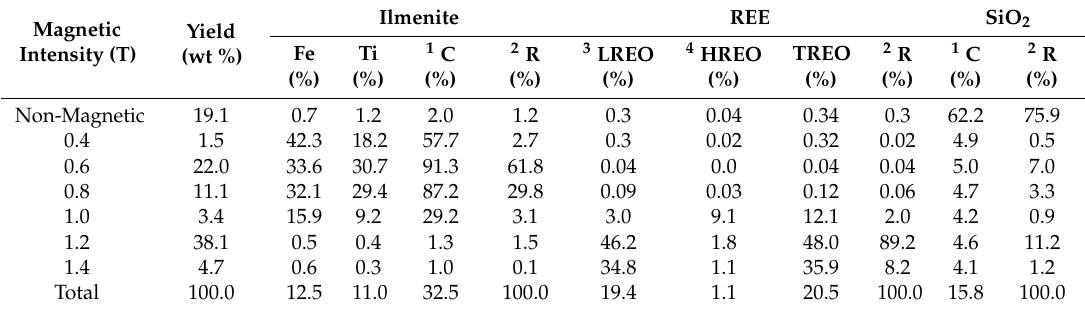
Table 4. The grade and recovery of main minerals at various magnetic intensity